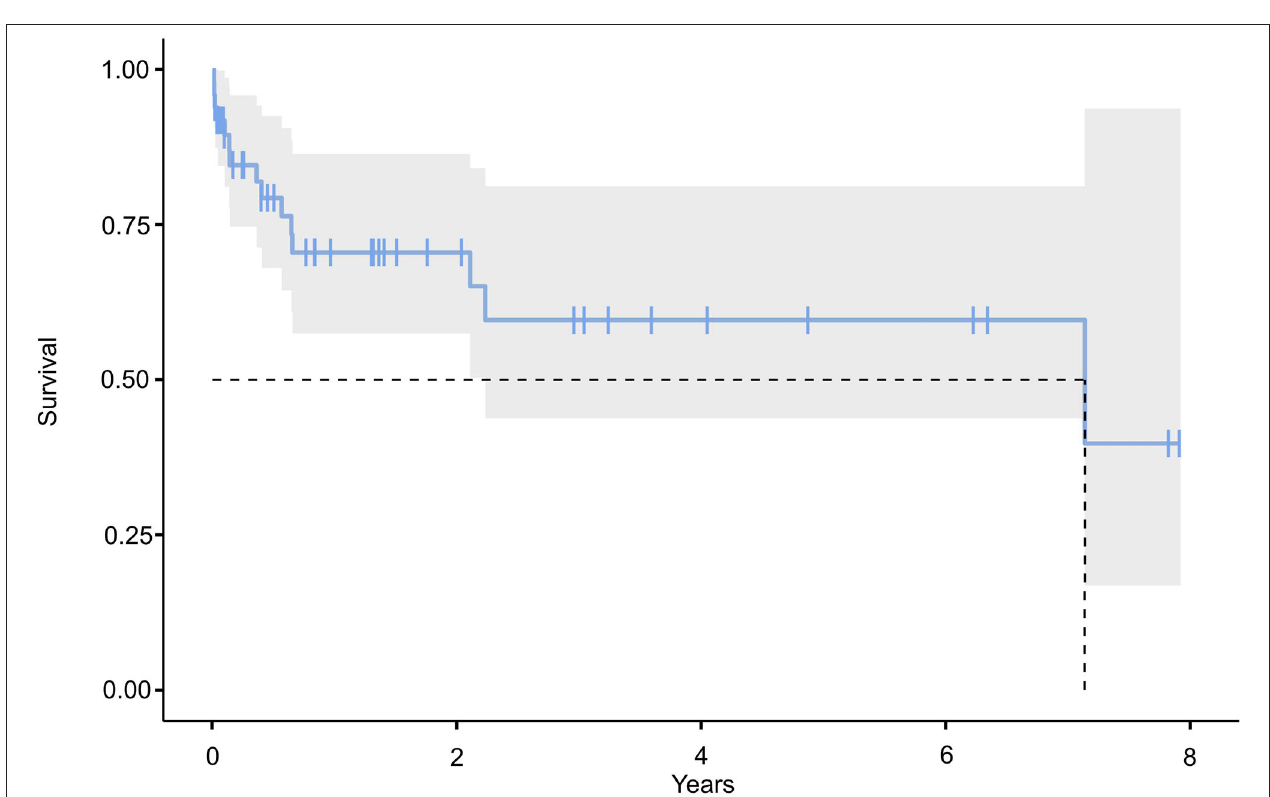
FIGURE 3 | Kaplan Meier estimation of overall